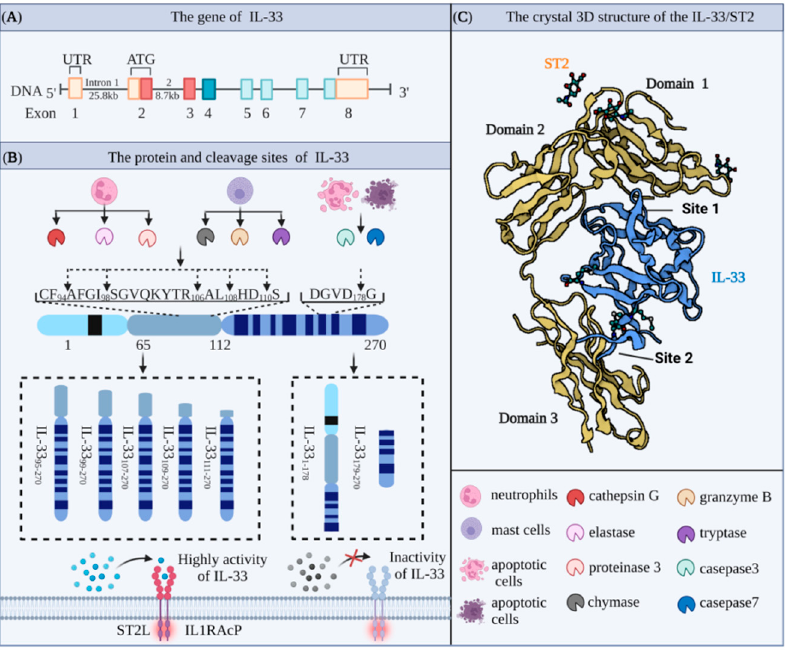
Figure 1. Molecular biological characteristics of IL-33 ( A ) The gene spans of human IL-33 (approximately 48 kb) contain eight exons, which are transcribed and translated into proteins containing 270 amino acids. ( B ) The full length of IL-33 is sheared to obtain different levels of active fragments. Cleaved by cathepsin, elastase, and proteinase released from neutrophils or chymase, Genzyme B, and tryptase released from mast cells, the highly active fragments of IL-33 (IL-33 95-270 , IL-33 99-270 , IL-33 107-270 , IL-33 109-270 , IL-33 111-270 ) can bind to the ST2L/IL-1RAcP dimer and activate downstream signaling pathways. In contrast, when the full length of IL-33 is cleaved by casepase3/7 released by apoptotic cells, it forms a fragment (IL-33 179-270 ) without biological activity. ( C ) The 3D structure of the IL-33/ST2 complex (Protein Data Bank ID:4KC3). IL-33 mediates cytokine activity through the structural domain with three Ig-like structural domains in the extracellular domain of ST2 on target cells. At Site 1, the acidic residues Glu144, Glu148, Asp149, and Asp244 of IL-33 interact with the ST2 basic residues Arg38, Lys22, Arg198, and Arg35, respectively, via a critical salt bridge. At Site 2, the acidic residue Glu165 of IL-33 interacts with Arg313 of ST2 via a salt bridge, and Tyr163 and Leu182 of IL-33 form significant hydrophobic structures with Leu246, Leu306, and Leu311 of ST2.